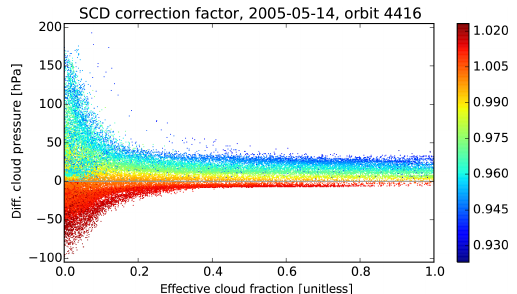
Figure 6. Difference in the effective cloud pressure due to the tem- perature correction (without correction minus with correction) plot- ted as a function of the effective cloud fraction. The colours of the symbols indicate the temperature correction factor γ